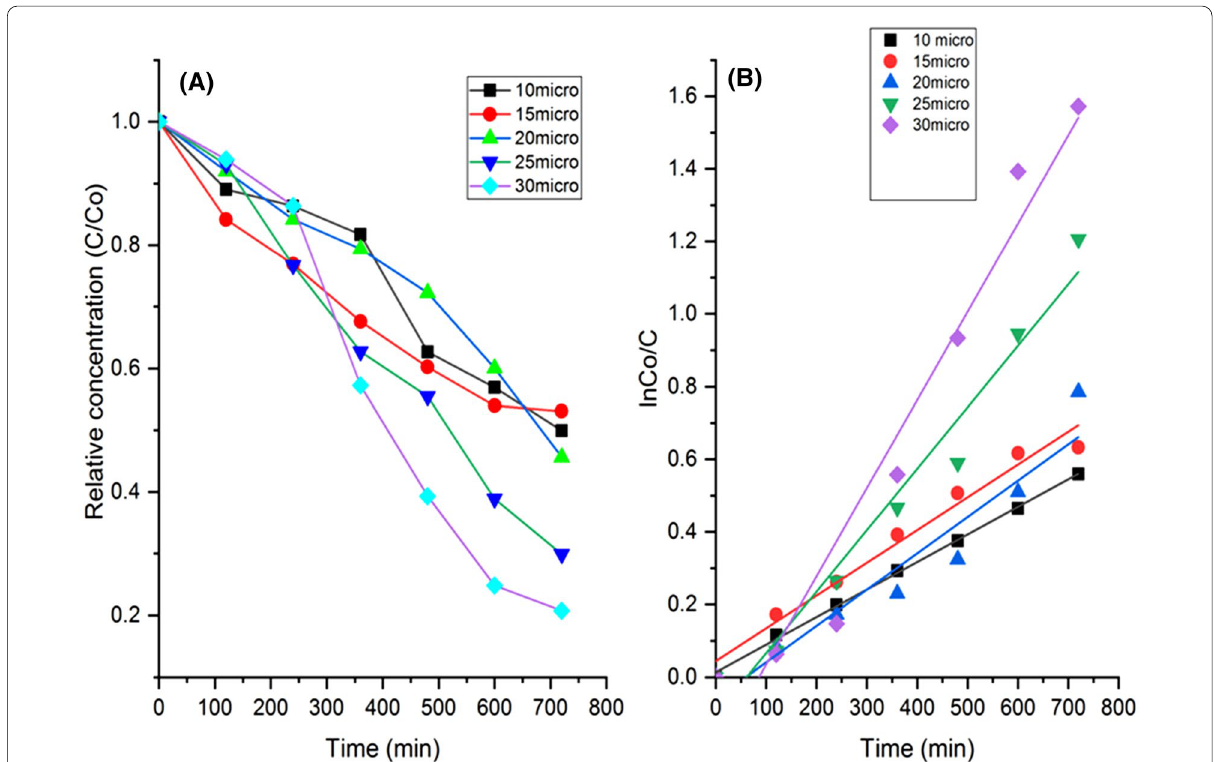
Fig. 8 A Plot of (C/C 0 ) versus time for the samples 1S5 and B Plot of Ln (C 0 /C) versus decay time for different dye concentrations of in the presence of nano-fluid sample 1S5